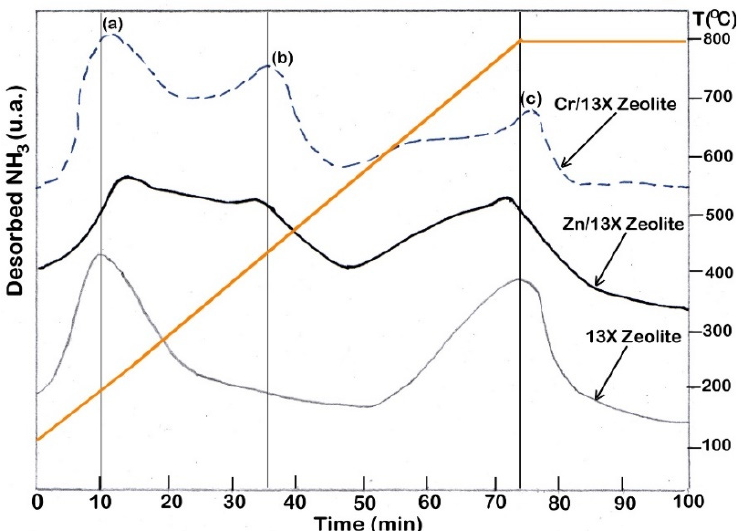
Figure 7. The profile of NH 3 -TPD curves for 13X zeolite, Cr/13X zeolite and Zn/13X zeolite. The peak (a) is characteristic to 13X zeolite and it also appeared for Zn/13X zeolite and Cr/13X zeolite